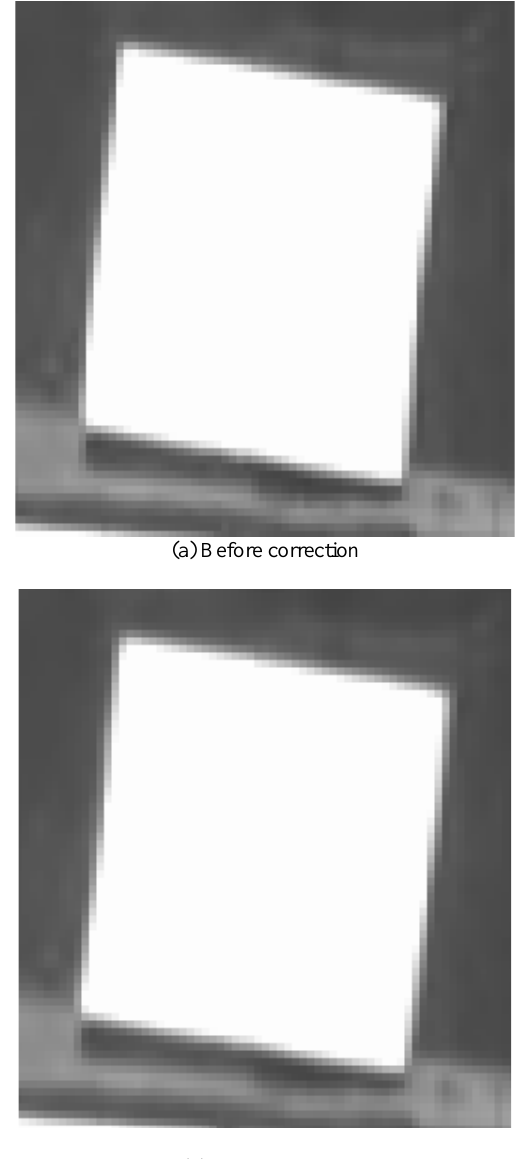
Figure 5. The target in the green rectangle in figure 7 before and after sensor correction (in left image, the red dashed line is the edge of the deformed target, and the green solid line is the true shape of the